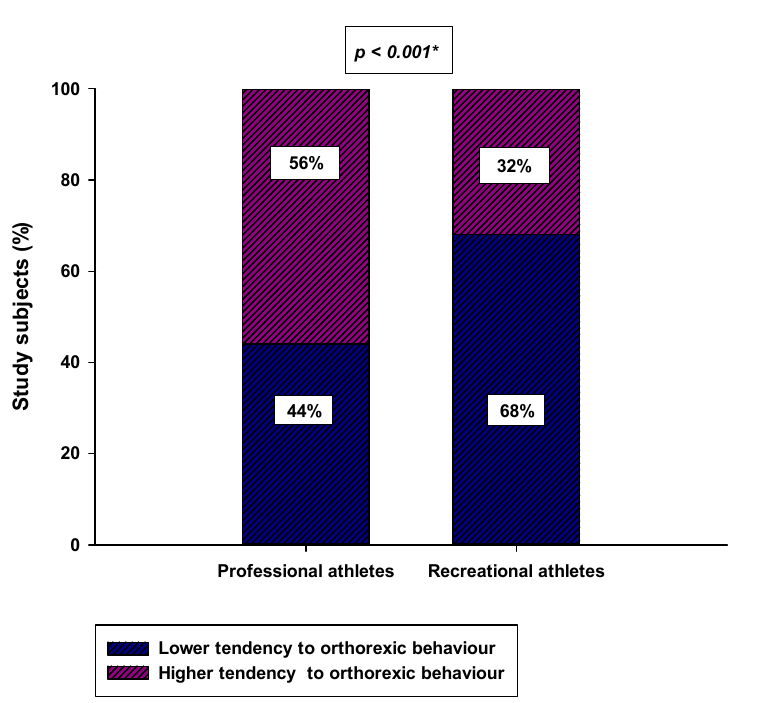
Figure 4. Difference in the number of participants with a tendency to ON (ORTO-15 score <35) between the professional athlete group ( N = 150) and the recreational group ( N = 150). * Chi-square test.